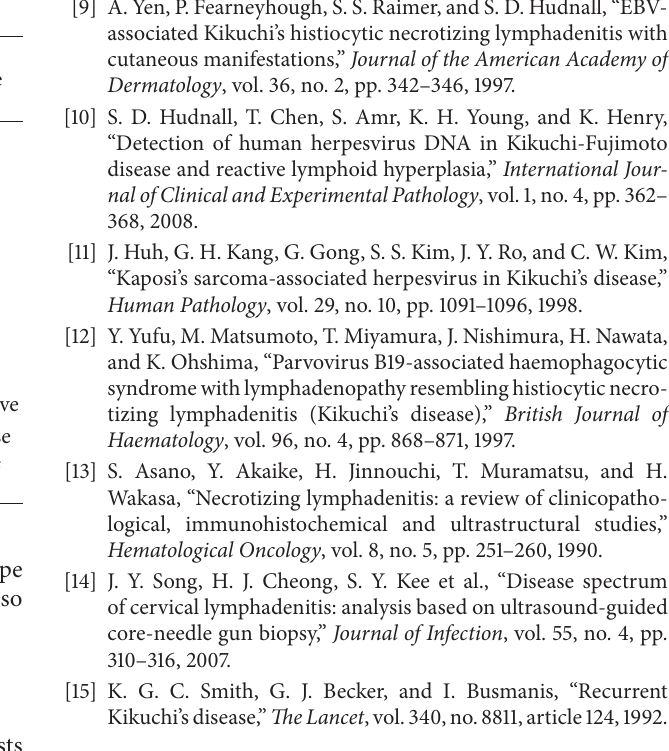
Table 1: Laboratory findings of KFD